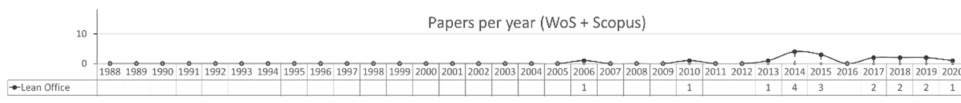
Figure 16. Lean office evolution.